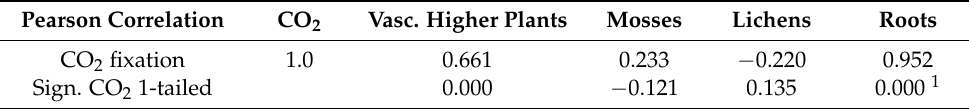
Table 8. Correlation and significance of harvested plants, n = 27